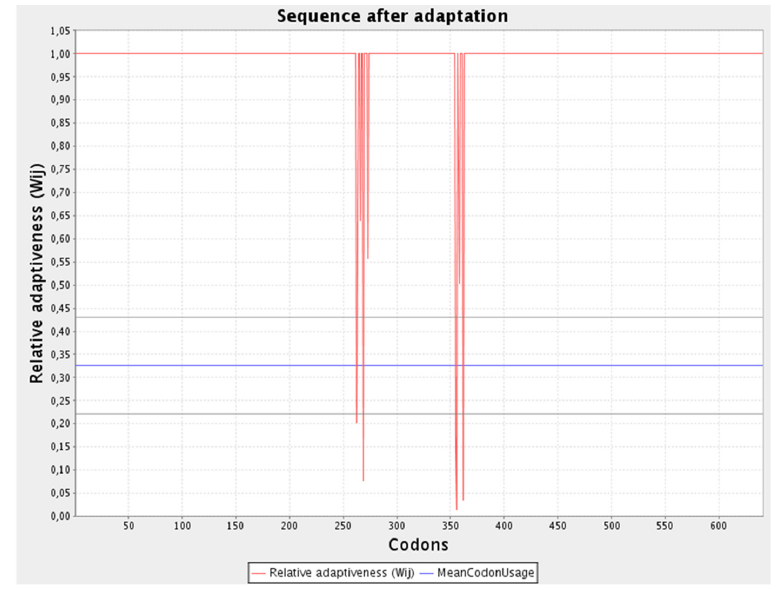
Figure 6. Sequence adaptation predicted via JCAT.